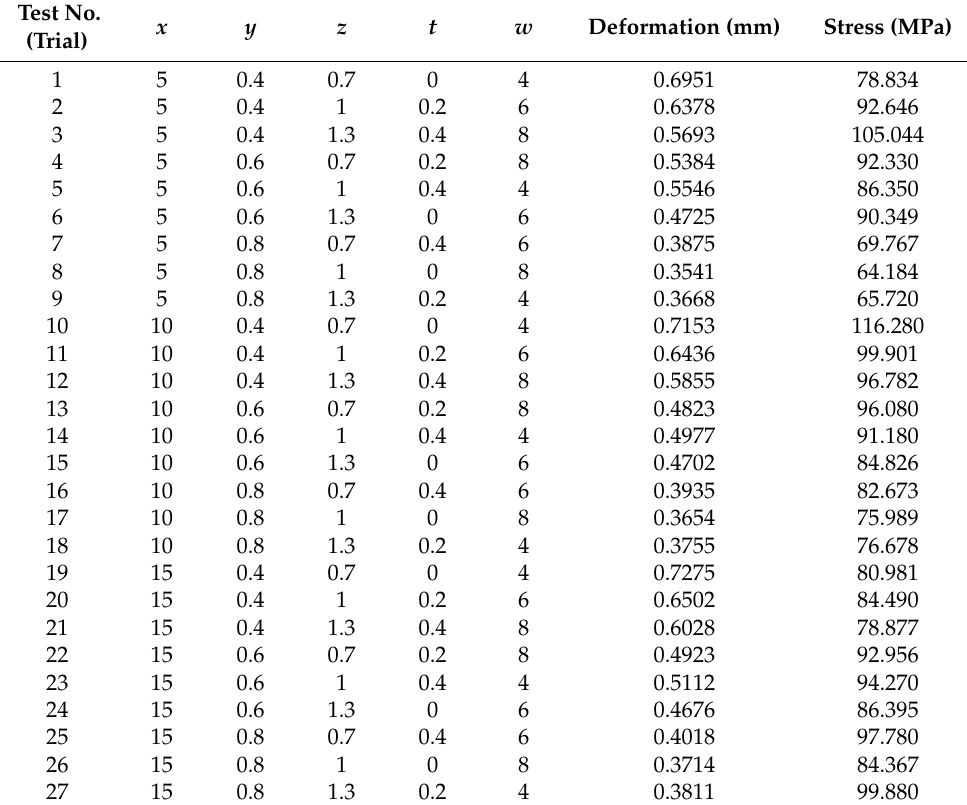
Table 2. Output response (including orthogonal arrays and numerical results with S/N). Test No. (Trial)